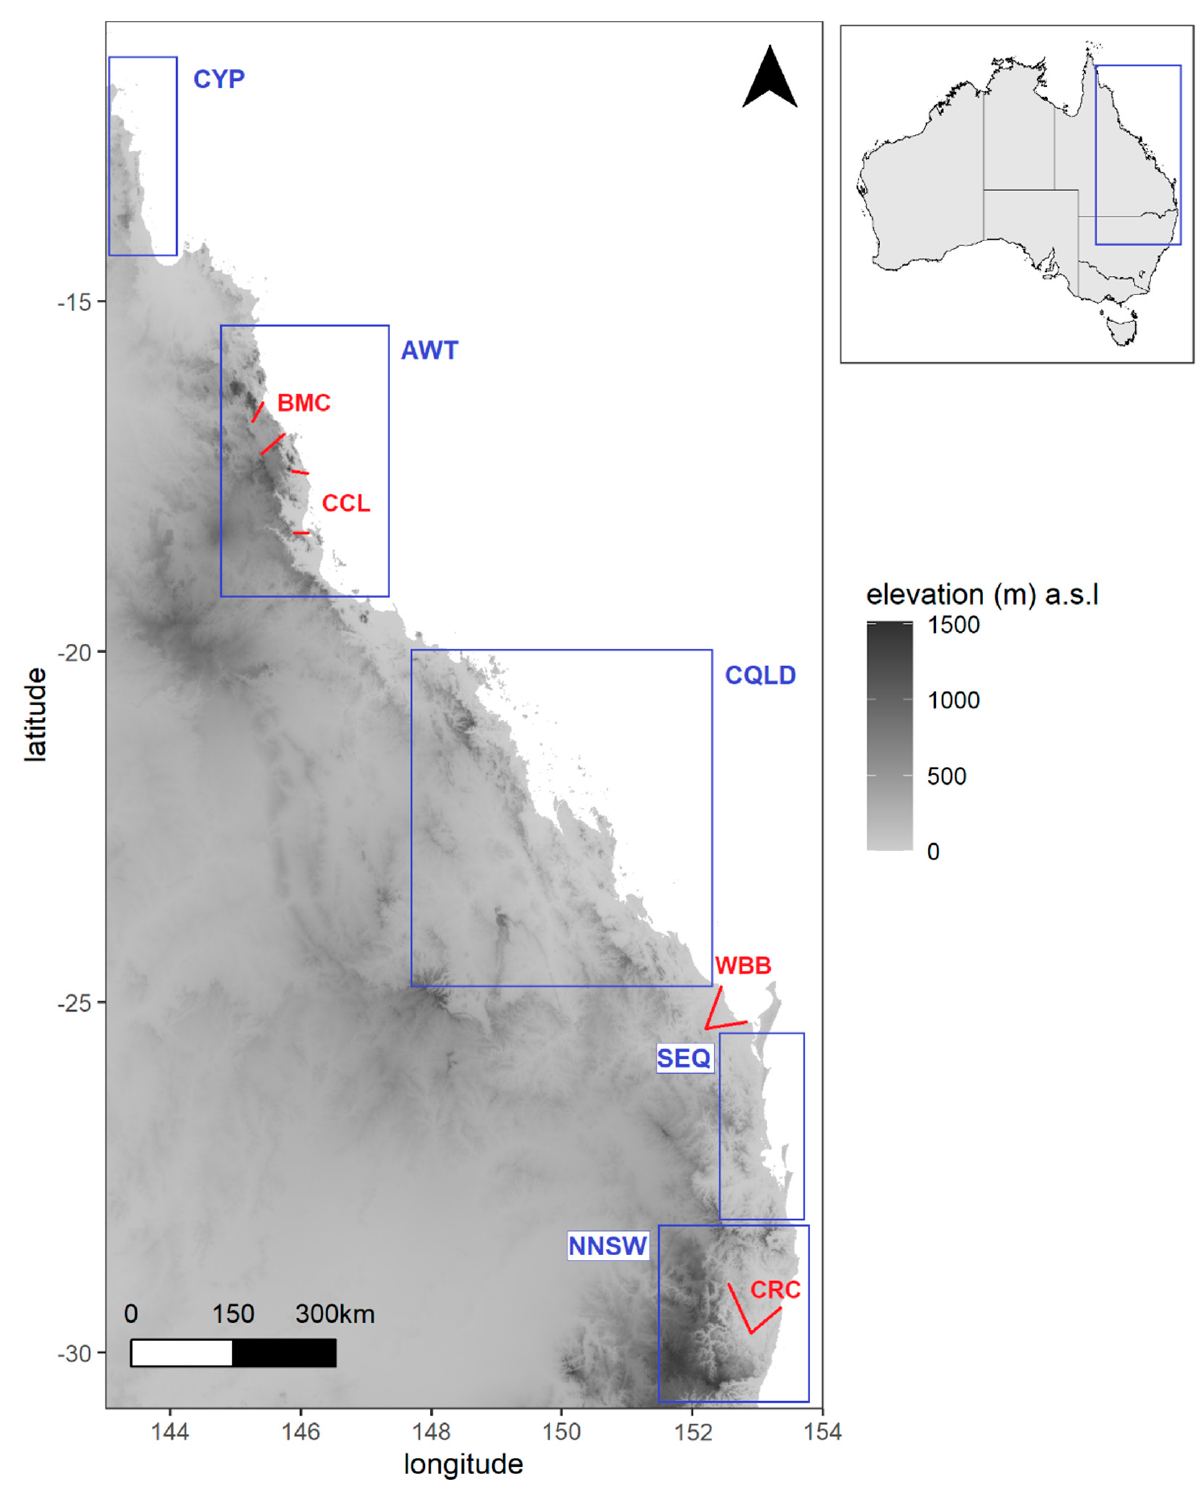
Figure 1. The study area in eastern Australia. Geographic regions separated by disjunctions of rainforest vegetation are indicated by the blue boxes. NNSW = Northern New South Wales, SEQ = Southeast Queensland, CQLD = Central Queensland, AWT = Australian Wet Tropics, CYP = Cape York Peninsula. Low elevation biogeographic barriers that structure the genomic variation in some of the study species are demarcated by red lines. CRC = Clarence River Corridor, WBB = Wide Bay-Burnett, CCL = Cairns-Cardwell Lowlands, BMC = Black Mountain Corridor.